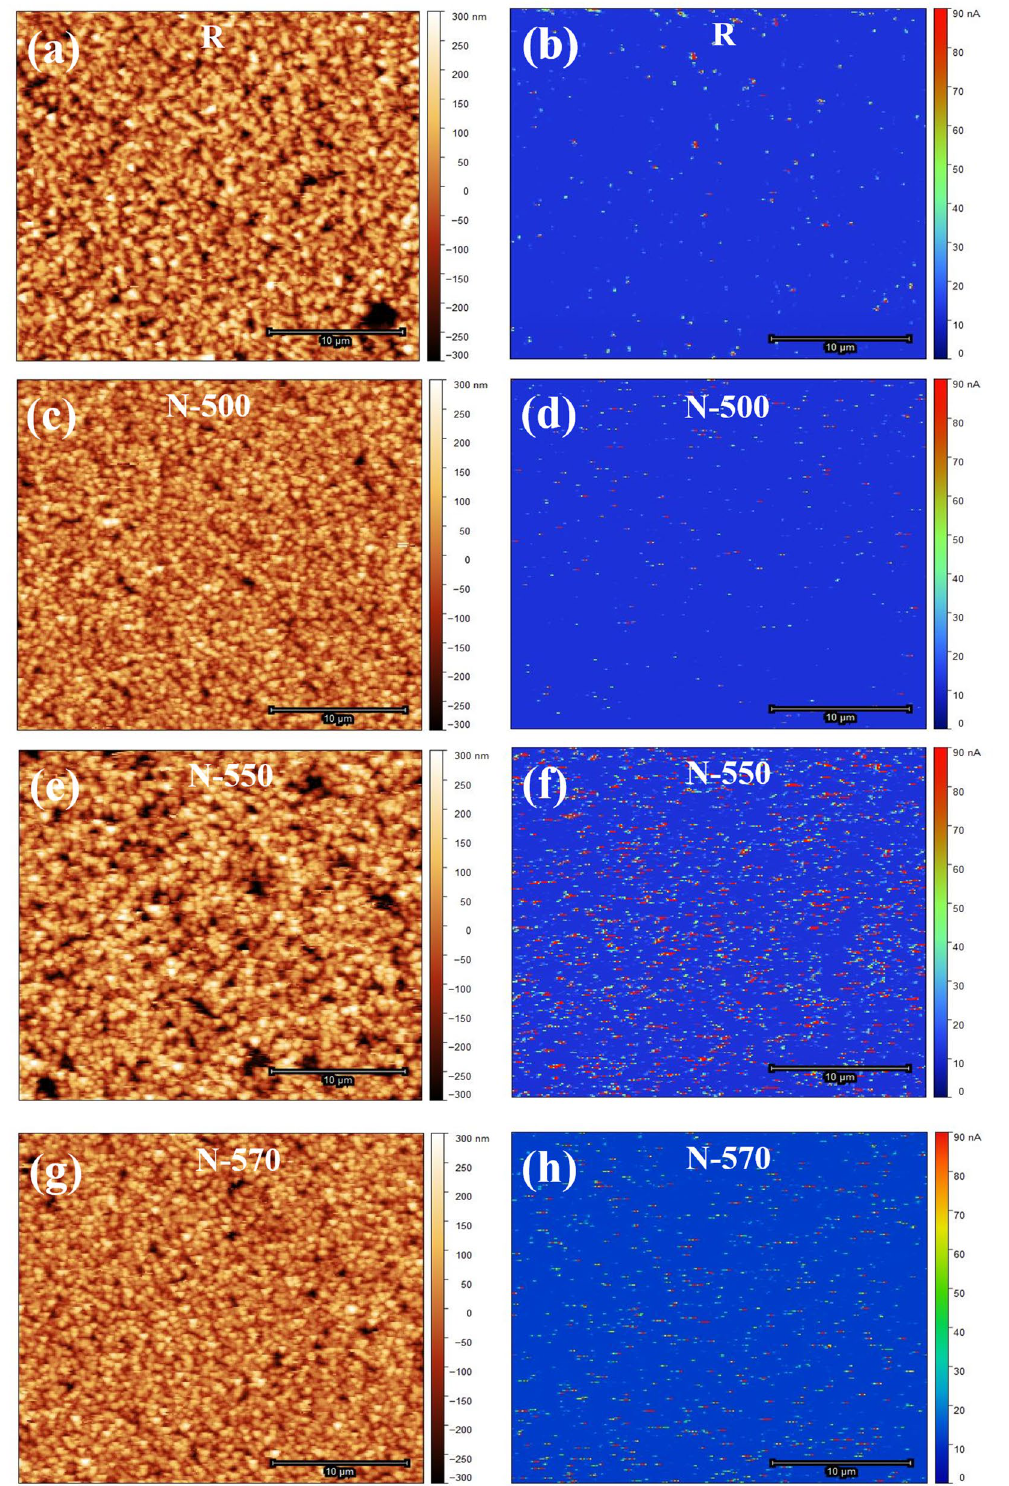
Figure 4. ( a , c , e , g ) Topography and ( b , d , f , h ) corresponding current map of R, N-500, N-550, and N-570 sample, respectively, using